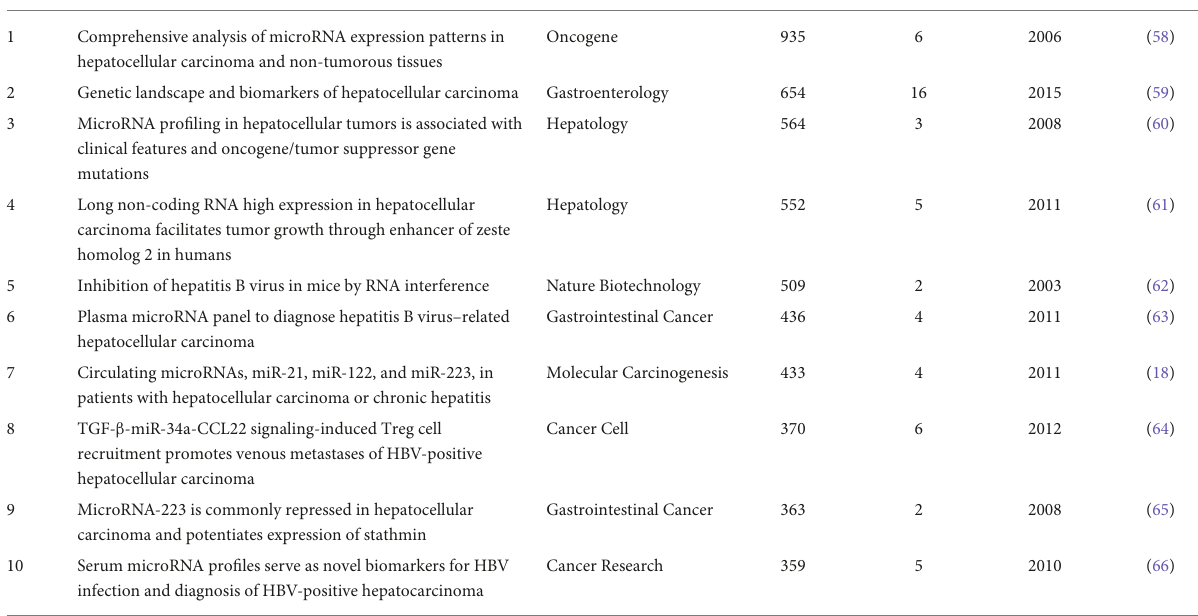
TABLE 2 The top 10 articles with the most